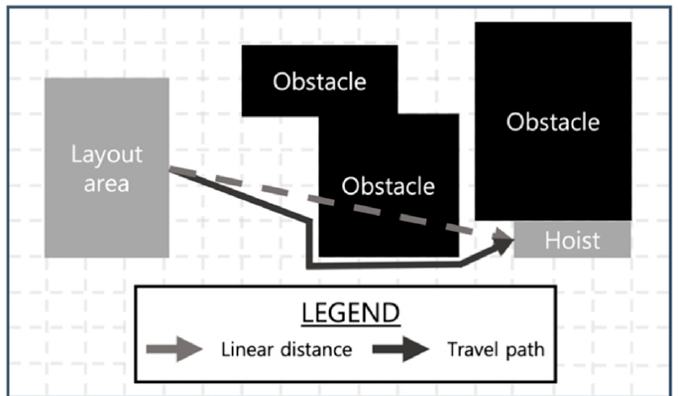
Figure 7. Linear and travel path distance algorithms for inter-facility distance constraint.